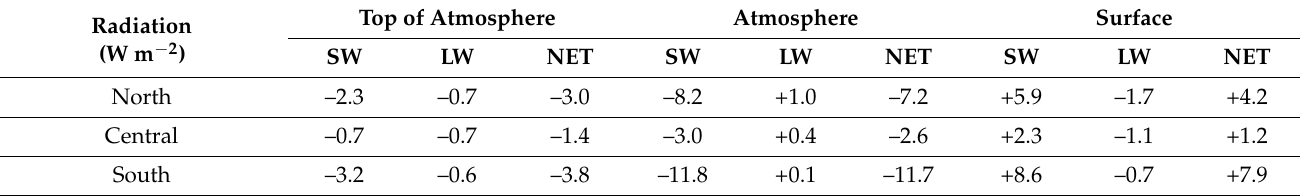
Figure 9. Changes (lockdown minus climatology) in shortwave (SW), longwave (LW), and NET (SW + LW) radiation flux (unites: W/m 2 ) at the top of the atmosphere (TOA), in the atmosphere (ATM), and at the surface (SFC) under clear-sky condition. Data are retrieved from CERES. Table 2. Changes (lockdown minus climatology) of the shortwave (SW), longwave (LW), and NET (SW + LW) radiation flux at the top of atmosphere, in the atmosphere, at the surface over North, Central, and South Indian subcontinent (Figure 1) during the lockdown period in 2020. Data are retrieved from the Clouds and the Earth’s Radiant Energy System (CERES). The lockdown period